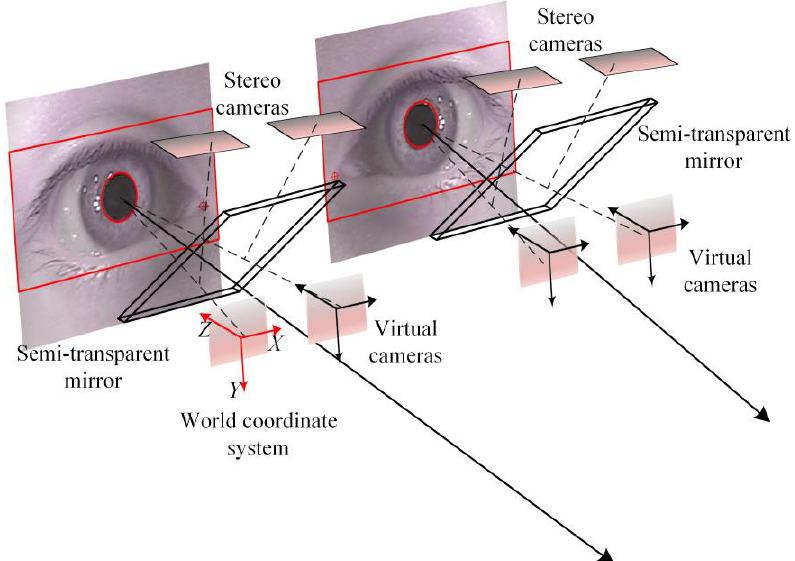
Figure 2. ( a ) The gaze tracker module of the left eye, and the shape and position of the stereo cameras, the light source, and the semi-transparent mirror are drawn in the figure; ( b ) the eye image captured by a Dikablis gaze tracker (Ergoneers GmbH, Manching, Germany); and ( c ) the eye image captured by proposed gaze tracker, the pupil and the eye corners can be identified clearly.